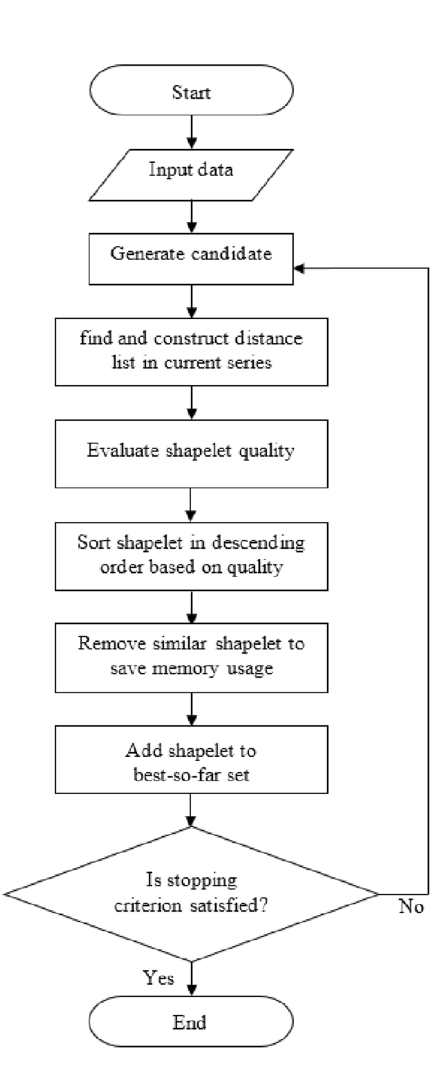
Figure 5. Flowchart of shapelet